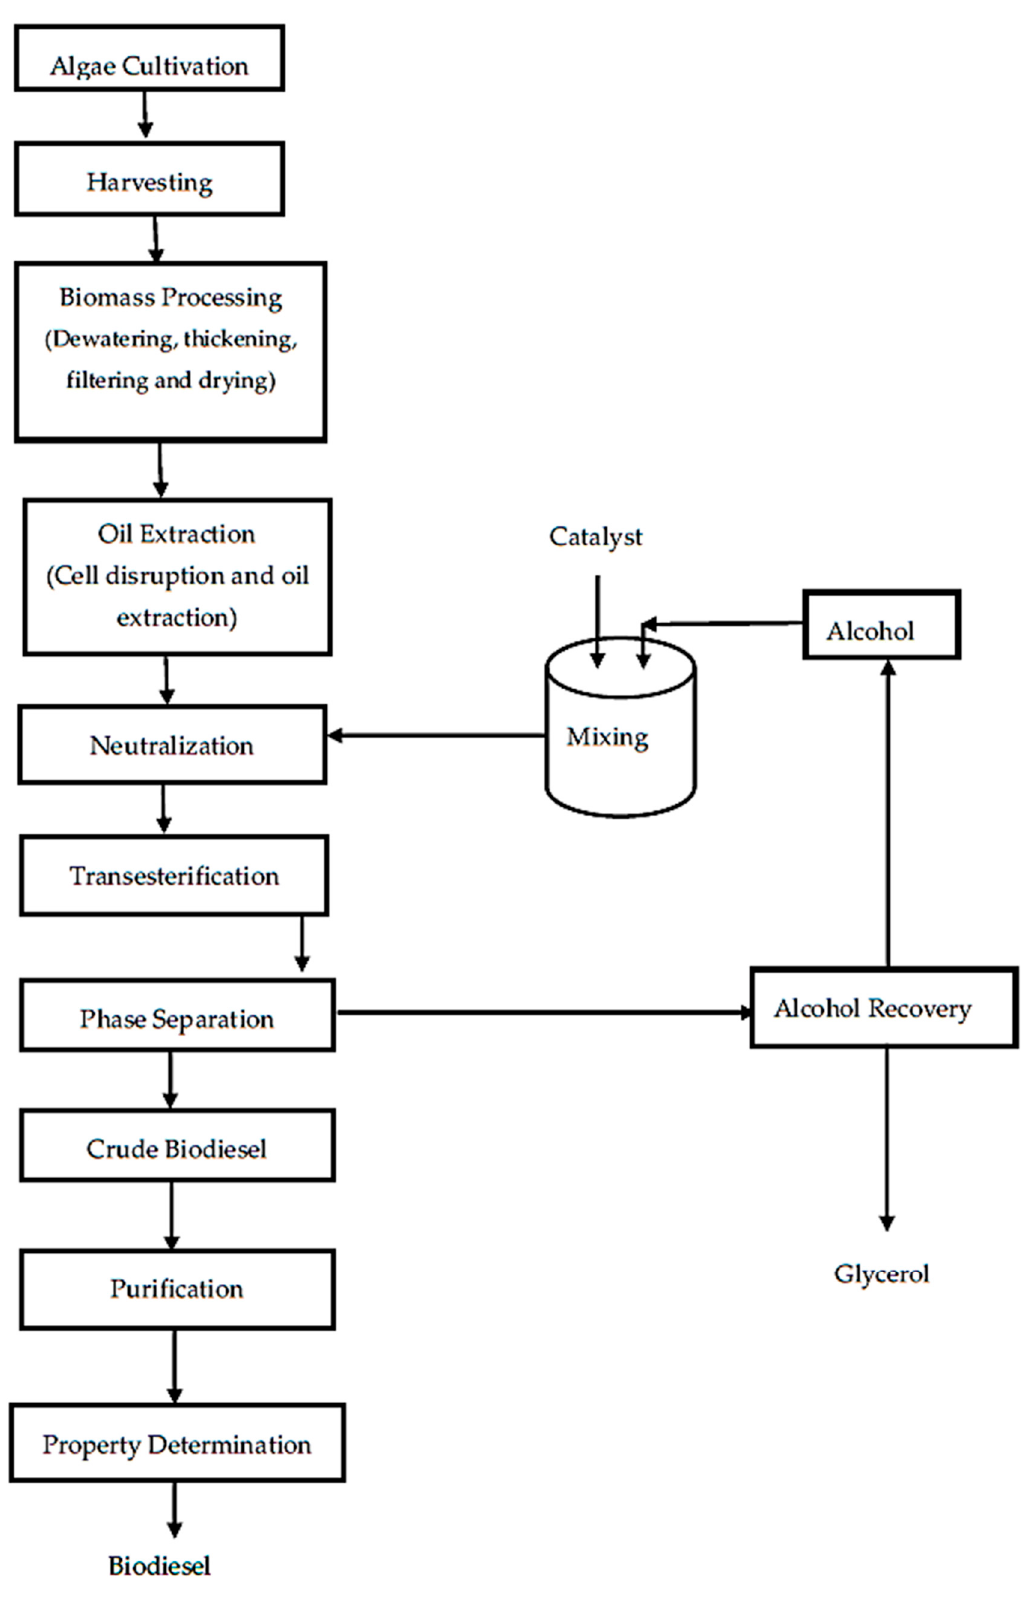
Figure 2. Flowchart of conventional biodiesel production from microalgae.